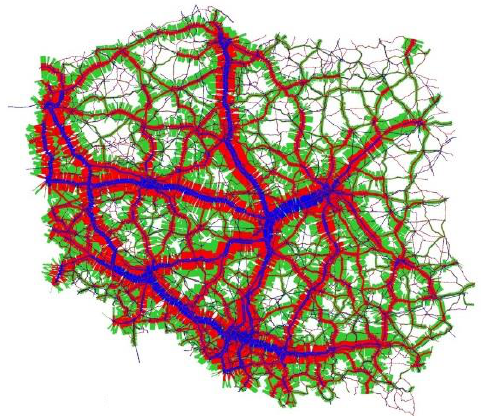
Fig. 3. The level of emissions of harmful compounds by passenger transport in 2015 in g/km (legend: blue line – HC, red line – CO, green line – NO x ) [8]